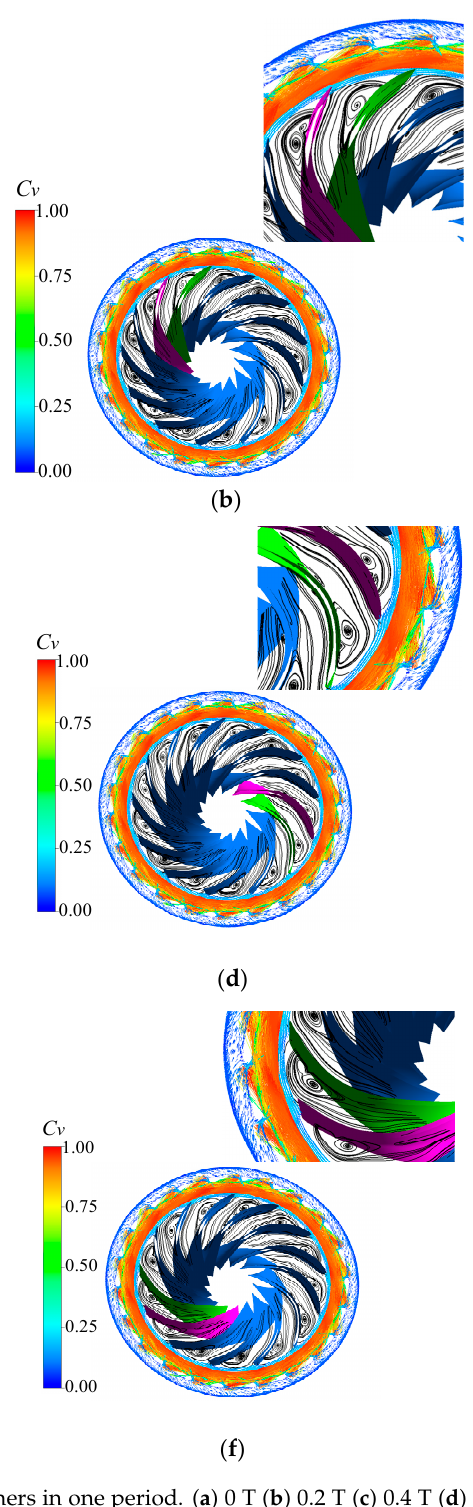
( b ) Figure 11. The axial water thrust change of the runner blade. ( a ) Time domain diagram of BF y . ( b ) Frequency domain diagram of BF y .